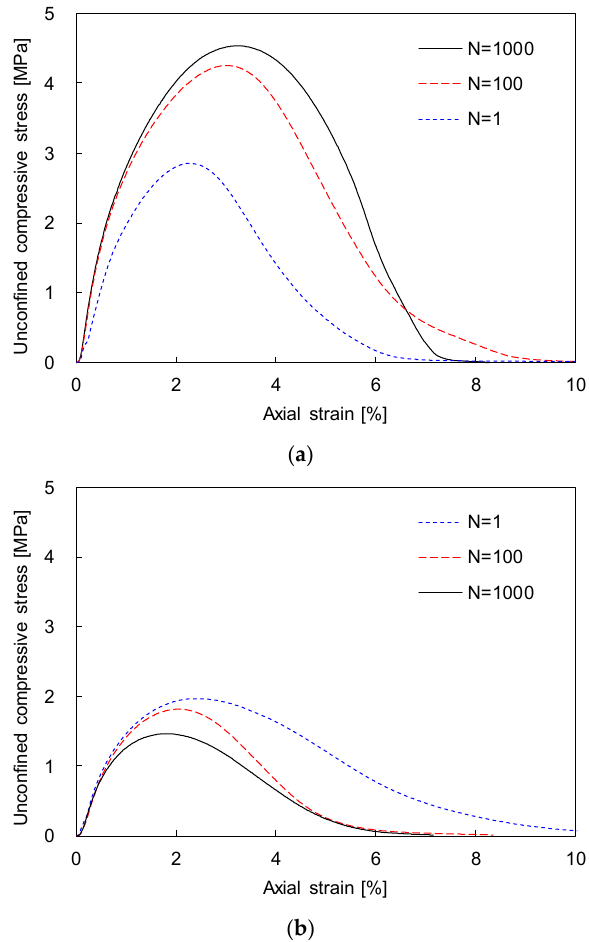
Figure 9. Typical unconfined compressive stress-strain curve of sand–silt mixtures subjected to N = 1, 100, and 1000: ( a ) SF = 30%; ( b ) SF = 70%.